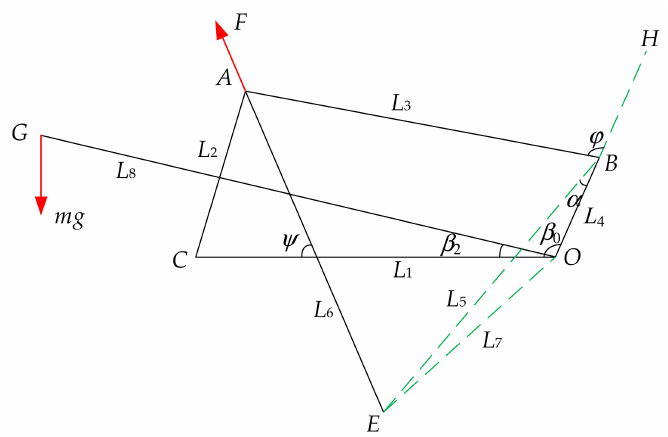
Figure 2. Schematic diagram of the multi-link